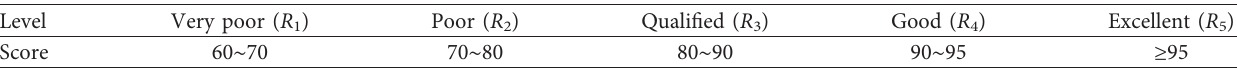
Table 5: Classification standard.